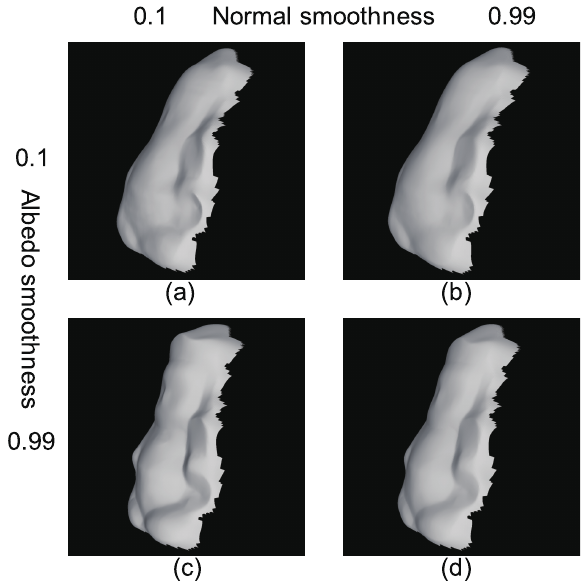
Figure 12. Parameter tuning problem of previous method: ( a ) sharp normal and sharp albedo; ( b ) smooth normal and sharp albedo; ( c ) sharp normal and smooth albedo; ( d ) smooth normal and smooth